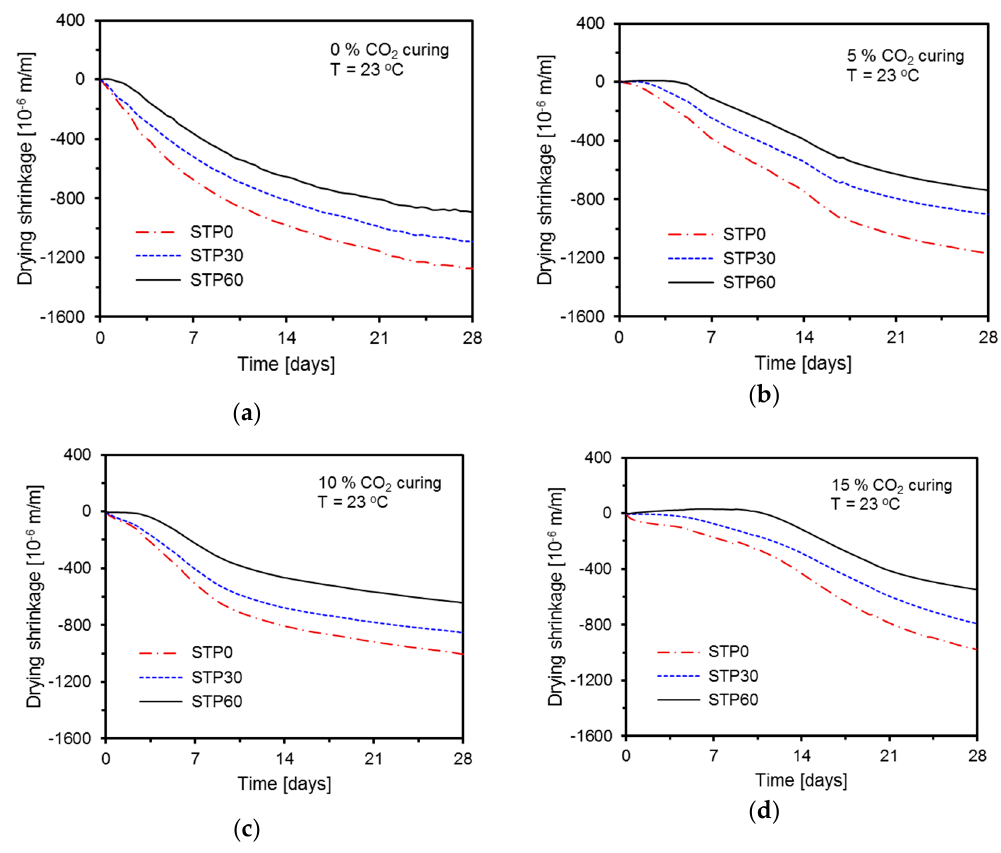
Figure 5. Drying shrinkages according to CO 2 concentration: ( a ) 0% CO 2 , ( b ) 5% CO 2 , ( c ) 10% CO 2 , and ( d ) 15% CO 2 .